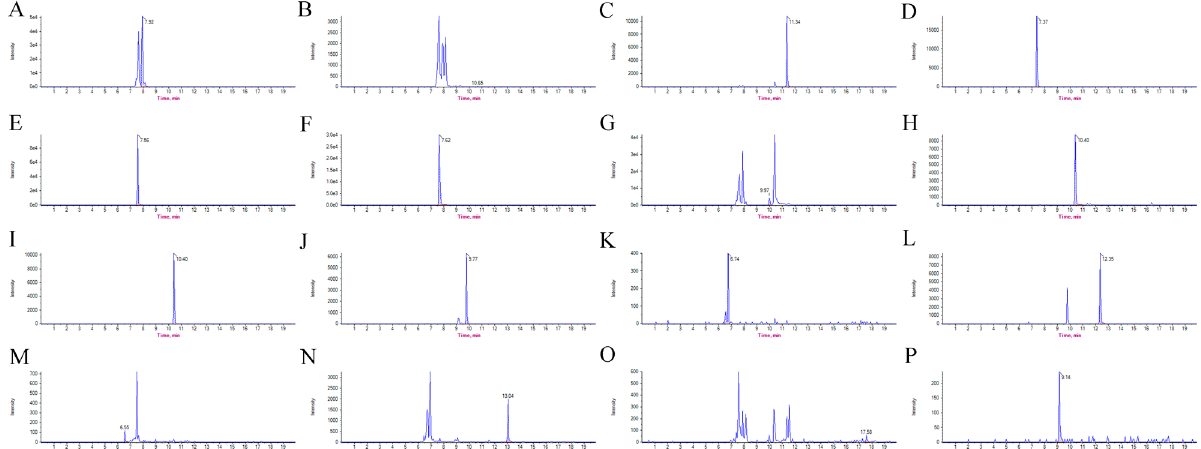
Figure 7. TIC diagrams of 16 flavonoid standards in the positive ion mode. (A) Icariin (retention time = 7.92 min). ( B) Icariside I (retention time = 10.65 min). ( C) Icariside II (retention time = 11.34 min). ( D) Epimedin A (retention time = 7.37 min). ( E) Epimedin B (retention time = 7.56 min). ( F) Epimedin C (retention time = 7.62 min). ( G) Sagittatoside A (retention time = 9.97 min). ( H) Sagittatoside B (retention time = 10.40 min). ( I) 2’’- O -rhamnosyl icariside II (retention time = 10.40 min). ( J) Baohuoside II (retention time = 9.77 min). ( K) Epimedoside A (retention time = 6.74 min). ( L) Desmethylicaritin (retention